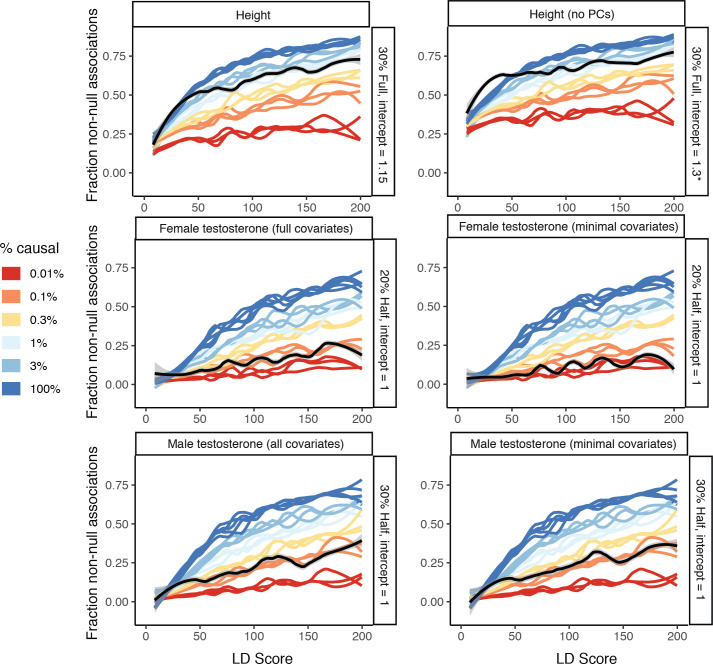
Effect of GWAS covariates on estimates.As noted in Figure 8—figure supplement 2, not including principal components can meaningfully effect estimates and produce upward bias, so we recommend adjusting for principal components (or using a suitable mixed model). In addition, we evaluated testosterone traits using two covariate sets: the complete set and a minimal age, age2, genotyping array, and principal components 1–20 that were used for the CBAT GWAS (due to the derivation from albumin, SHBG, and testosterone, and the difference in batch between these, Materials and methods). For male testosterone the effect of different covariates was negligible, while for female testosterone, the estimate was slightly lower with the minimal covariates. We recommend optimizing covariates to the sample and traits under study to maximize the interpretability of the causal variant estimation.